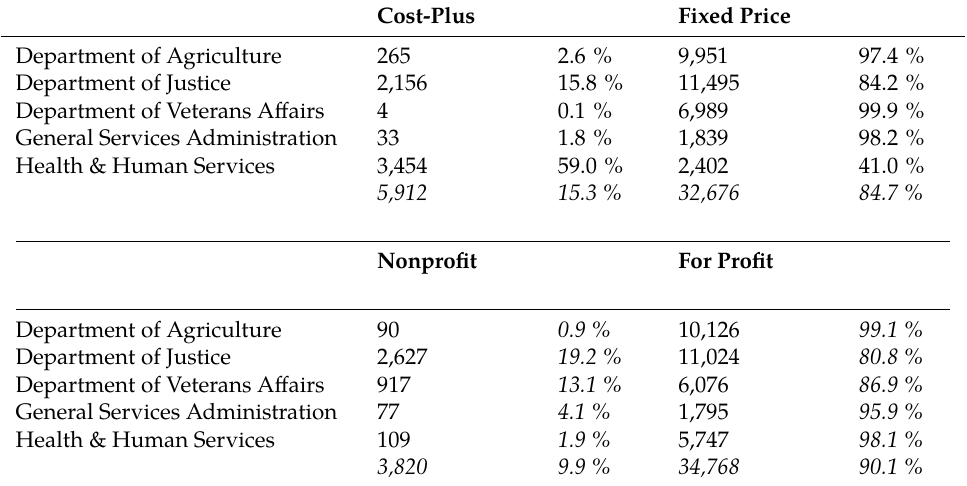
Table 1: Full sample tablulation by contract